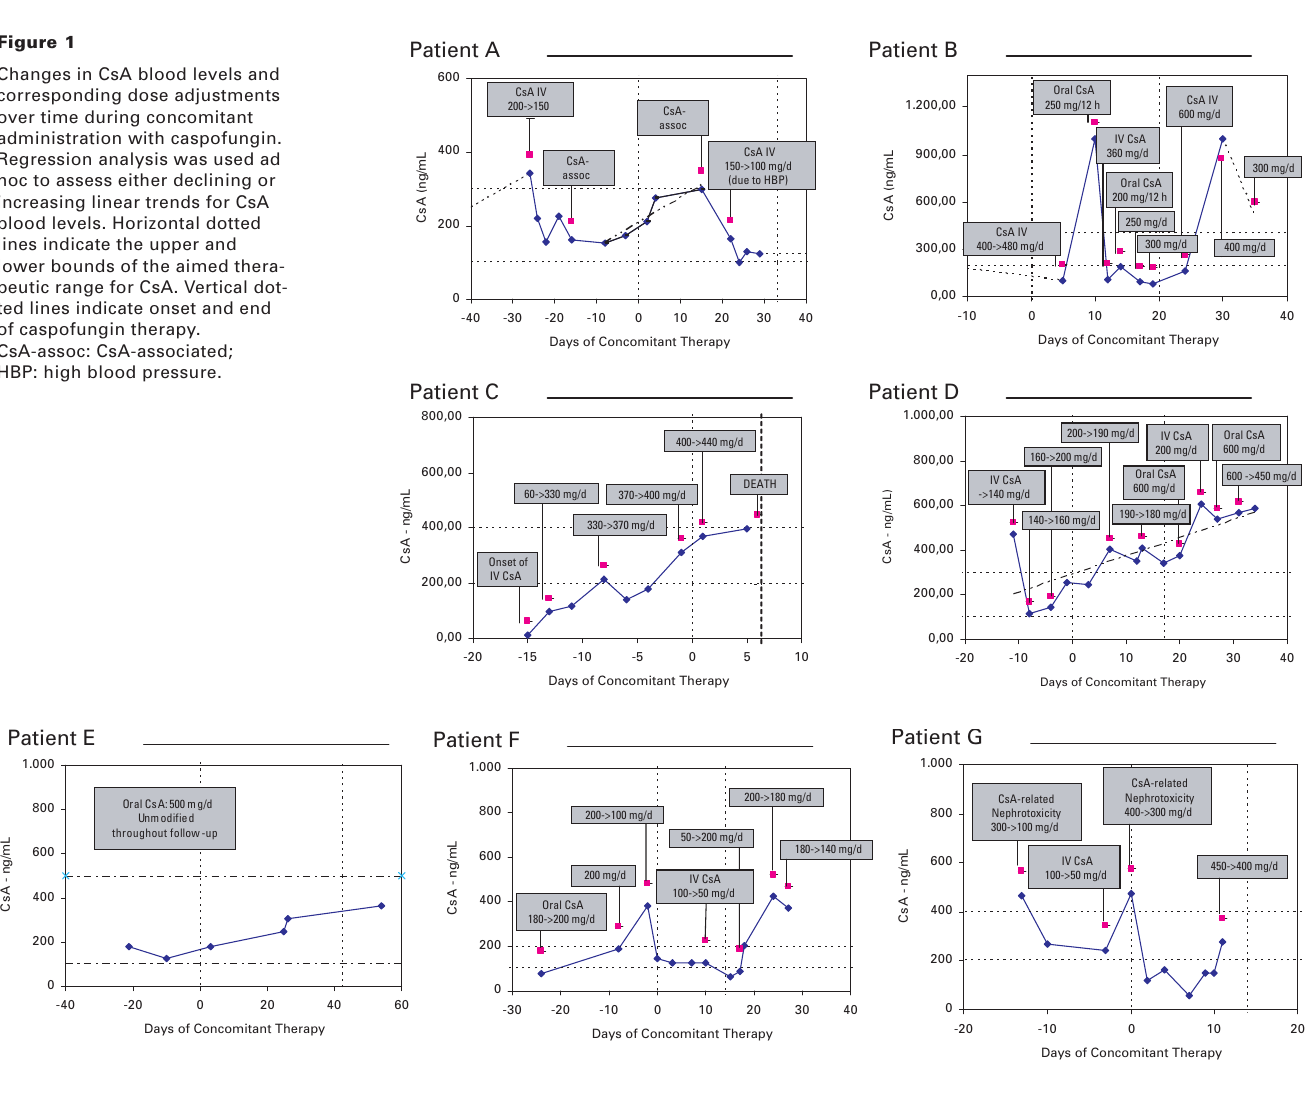
Figure 1 Changes in CsA blood levels and corresponding dose adjustments over time during concomitant administration with caspofungin. Regression analysis was used ad hoc to assess either declining or increasing linear trends for CsA blood levels. Horizontal dotted lines indicate the upper and lower bounds of the aimed thera- peutic range for CsA. Vertical dot- ted lines indicate onset and end of caspofungin therapy. CsA-assoc: CsA-associated; HBP: high blood